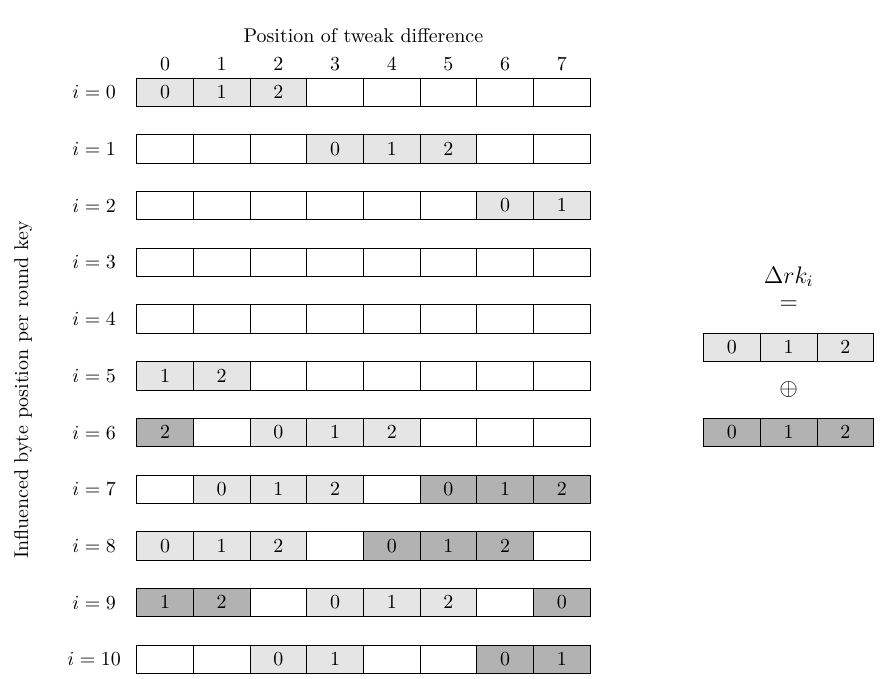
Figure 2: Visualization of the round key differences as a function of the tweak difference.